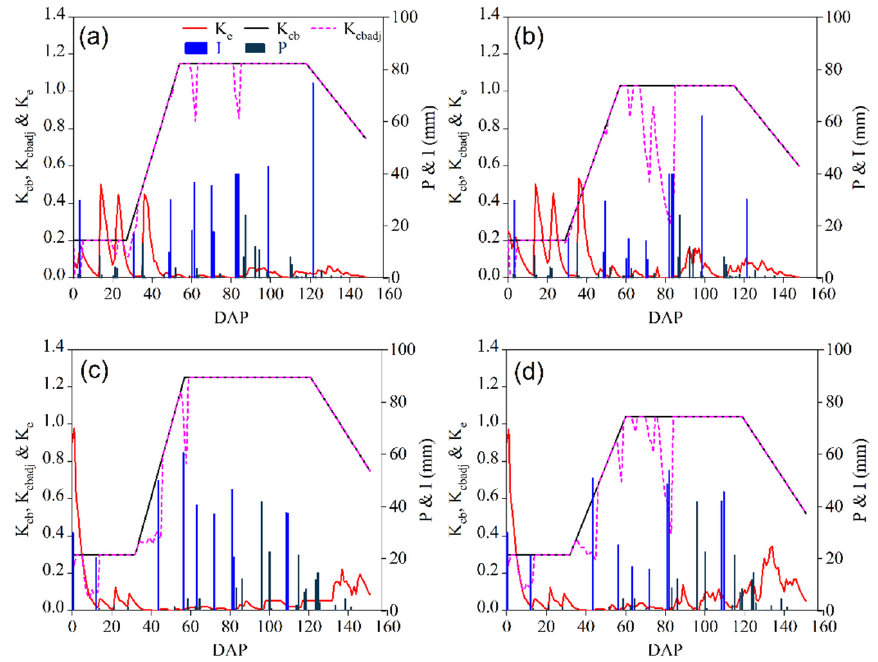
Figure 4. Dynamic variations of basic crop coefficient (K cb ), actual adjustment K cb (K cbadj ) and soil evaporation coefficient (K e ) for two water treatments (T1 and T2) with days after planting (DAP) during the whole growth period of maize in ( a , b ) and 2018 ( c , d